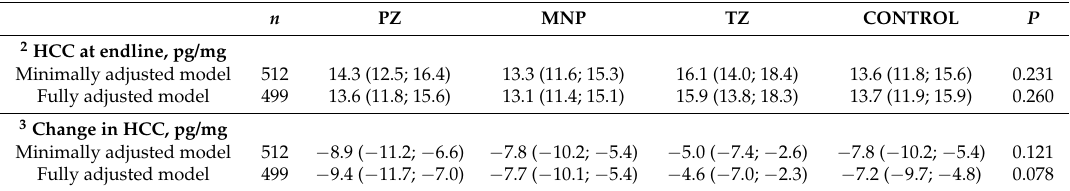
Table 2. Effects of daily preventive zinc, micronutrient powder or therapeutic zinc for diarrhea on hair cortisol concentrations (HCC) among Laotian children 1